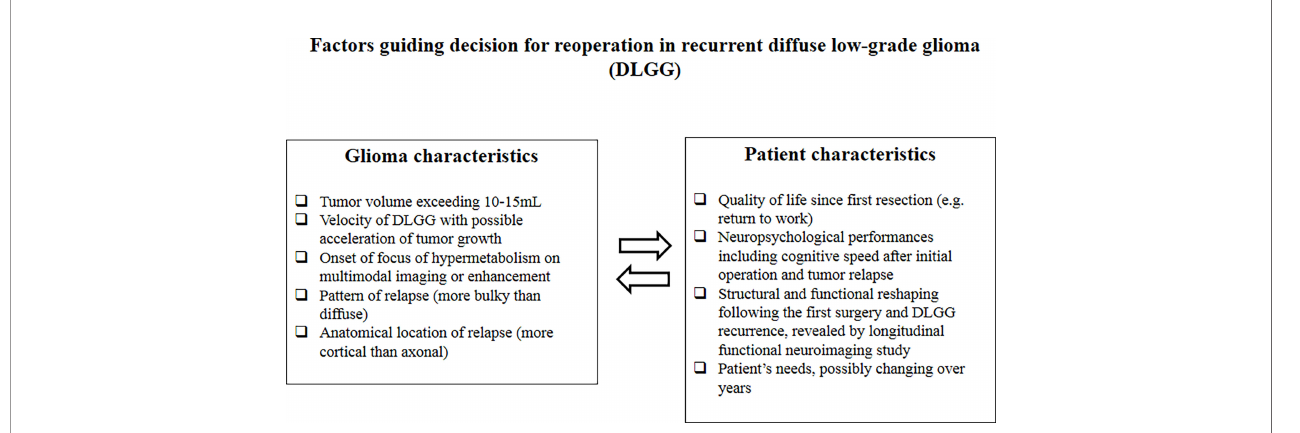
FIGURE 1 | Factors guiding decision for reoperation in recurrent diffuse low-grade glioma